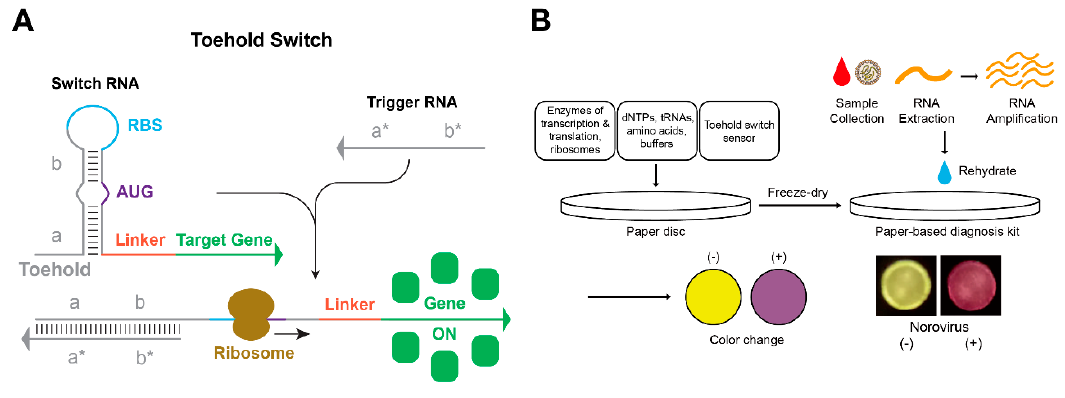
Figure 5. Toehold switch mechanism and application for paper-based diagnostics. ( A ) Mechanism of toehold switch. Linear-linear interaction between switch RNA and trigger RNA initiates from the toehold region. The resulting conformation of switch-trigger complex makes ribosome binding site (RBS) and start codon (AUG) available for ribosome access. ( B ) Freeze-dried paper-based diagnostic kit using toehold switch as a synthetic sensor. LacZ was used as a reporter gene so that the change of color could be checked by the naked eye.